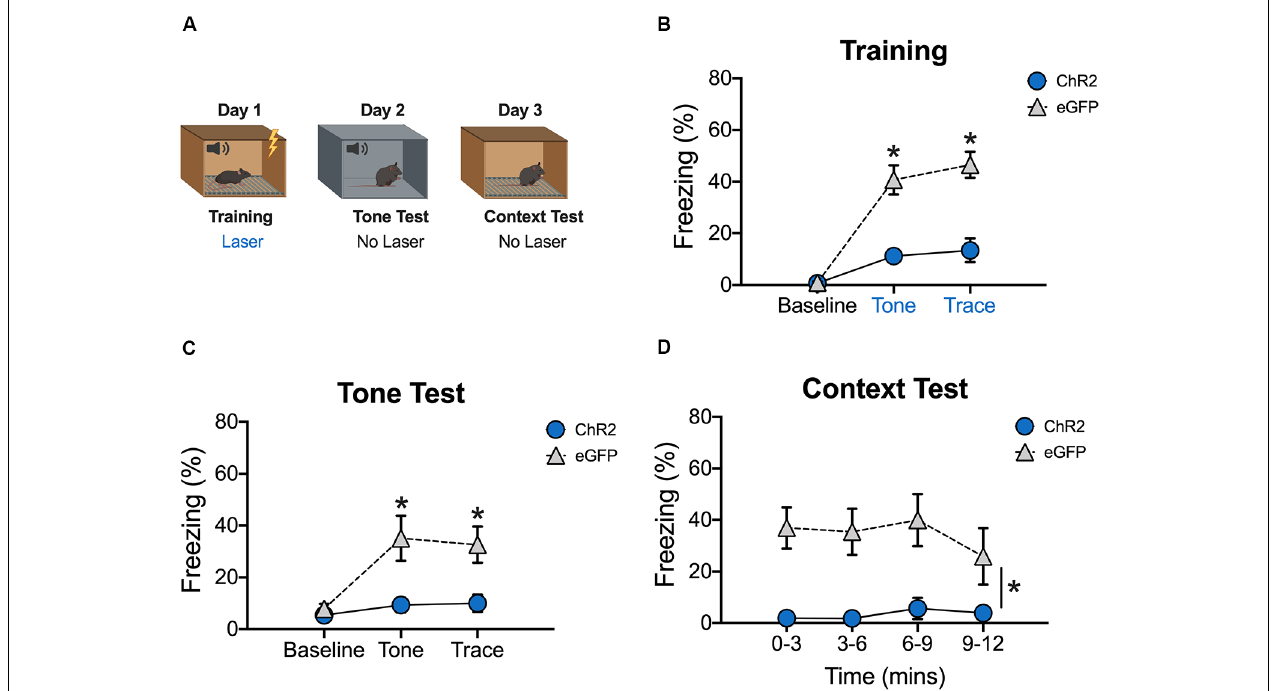
FIGURE 3 | Stimulation of dCA1 during trace fear encoding impairs memory acquisition. (A) Schematic of behavioral paradigm. On day 1, animals underwent trace fear conditioning with blue light (20 Hz) delivered to dCA1 during each training trial. The next day, mice underwent a tone memory test in a novel context with no laser stimulation. Twenty-four hours later, mice were placed back in the conditioning environment for a context memory test without light delivery. (B) Freezing during the training phase of trace fear conditioning (Mean ± SEM). (C) Freezing during the tone test (Mean ± SEM). (D) Freezing during the context test (Mean ± SEM). Blue x-axis labels denote periods during which the laser was delivered. In all behavioral panels, blue represents the ChR2 group and gray represents the control group. ∗ p < 0.05 relative to control.